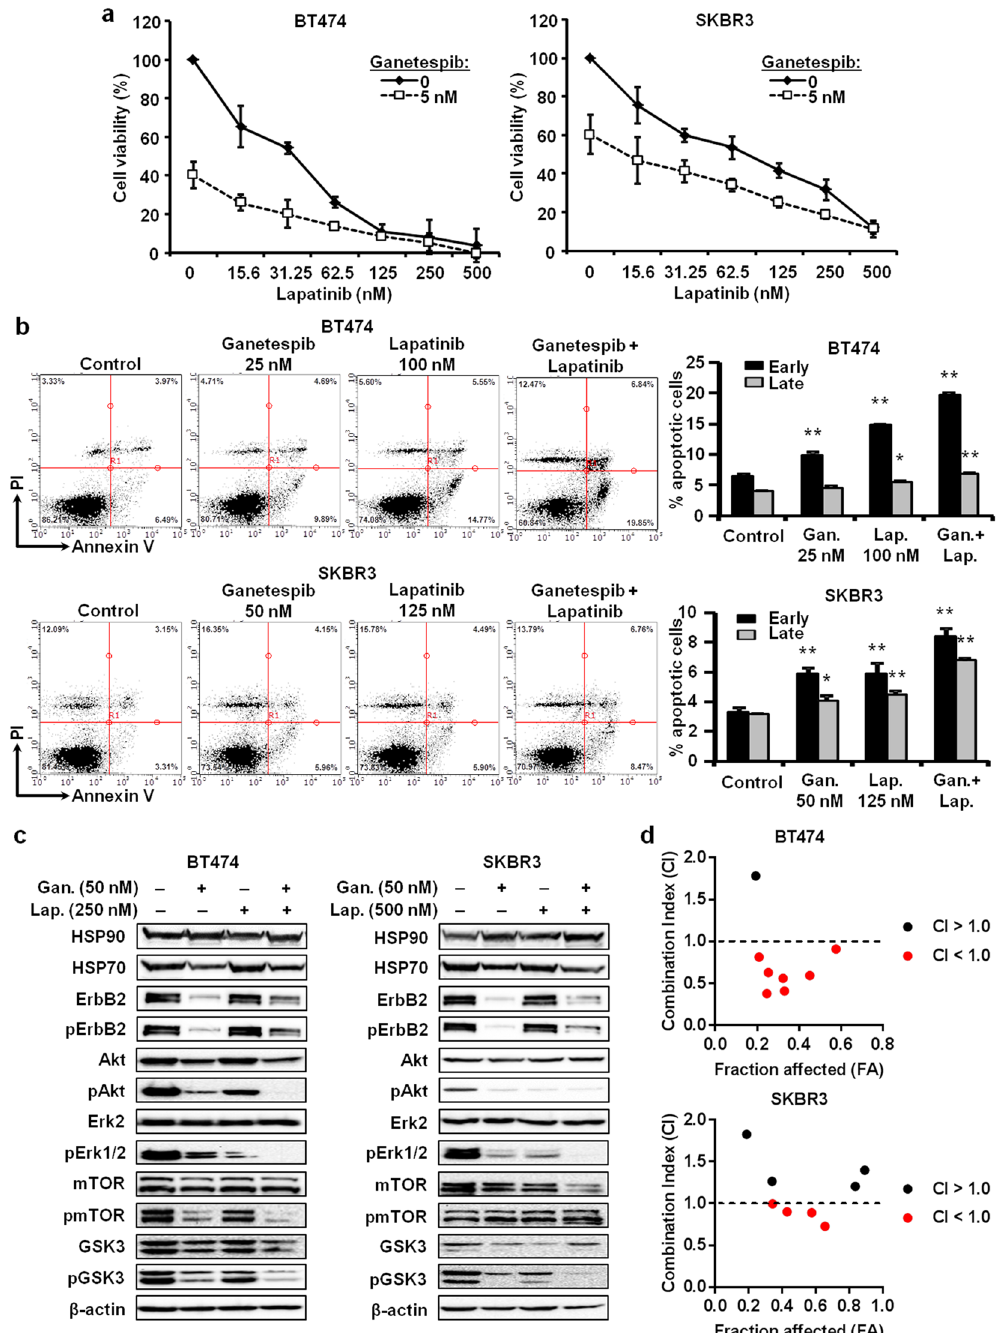
Figure 8. Ganetespib potentiates the anti-cancer effects of lapatinib in ErbB2 + breast cancer cells. ( a ) BT474 and SKBR3 cells were treated with ganetespib (0 or 5 nM) and lapatinib (0, 15.6, 31.25, 62.5, 125, 250, or 500 nM) for 5 days, followed by an MTT assay to assess cell viability. ( b ) BT474 and SKBR3 cells were treated with ganetespib alone (25 or 50 nM), lapatinib alone (100 or 125 nM), or ganetespib + lapatinib for 24 hours. Then, cells were Annexin V/PI-stained and analyzed with flow cytometry. The percentages of cells in early (Annexin V + /PI − ) and late (Annexin V + /PI + ) stages of apoptosis are graphed in the panels to the right of the representative dot plots. ( c ) BT474 cells were treated with ganetespib (50 nM) + / − lapatinib (250 nM) for 16 hours, and SKBR3 cells were treated ganetespib (50 nM) + / − lapatinib (500 nM) for 16 hours. Then, Western blot analysis was performed to detect the expression and activation/phosphorylation of the indicated markers. Cropped Western blot images are shown at the target molecular weights for the indicated markers. ( d ) BT474 and SKBR3 cells were treated with a series of increasing doses of ganetespib and lapatinib for 5 days. Then the viable fraction of each cell line (fraction affected; FA) was determined with an MTT assay. The Combination Index (CI) was calculated using CompuSyn software and graphed for each cell line. Dose combinations with a CI < 1.0 are highlighted in red. All values are presented as the means ± S.E. ( * P ≤ 0.05; ** P ≤ 0.01 as compared to the corresponding untreated